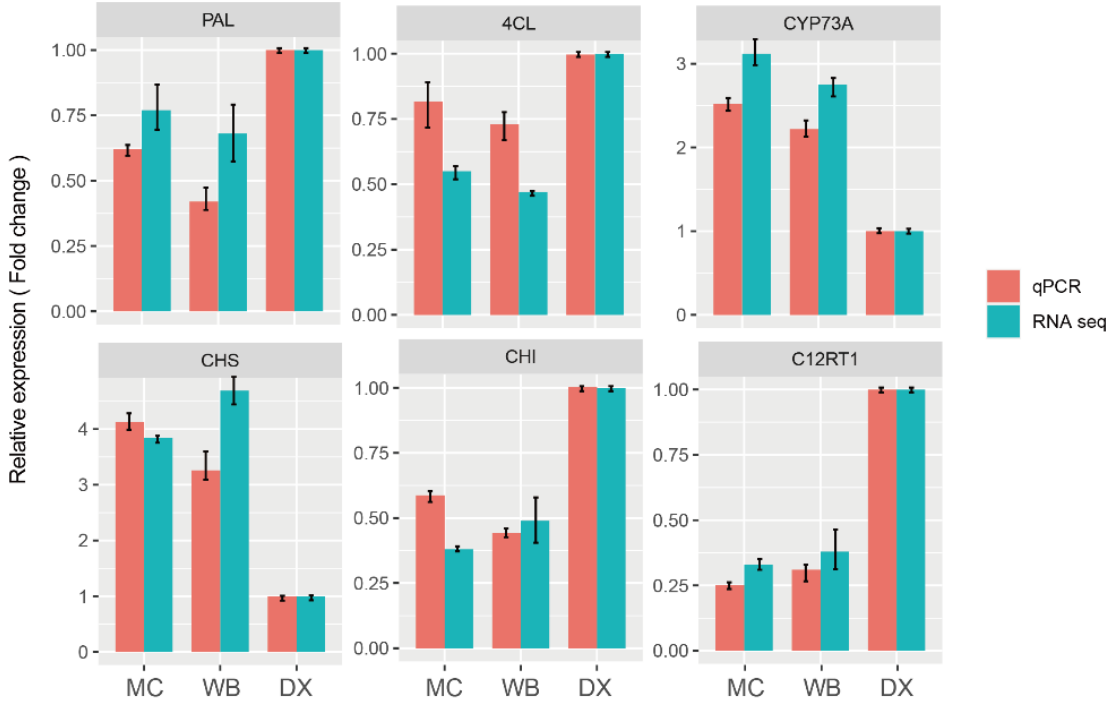
Figure 7. qRT-PCR validation profiles of six selected genes. The expression levels of genes in DX were used as the reference state, which was set to 1, and fold change values are shown here.